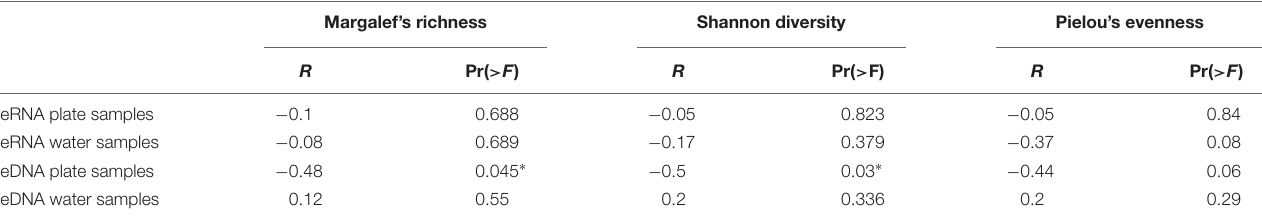
TABLE 1 | Linear regressions between alpha diversity indices of the metabarcoding dataset and corresponding droplet digital PCR copy numbers for the RNA and DNA data and split between plate and water samples. Margalef’s richness Shannon diversity Pielou’s